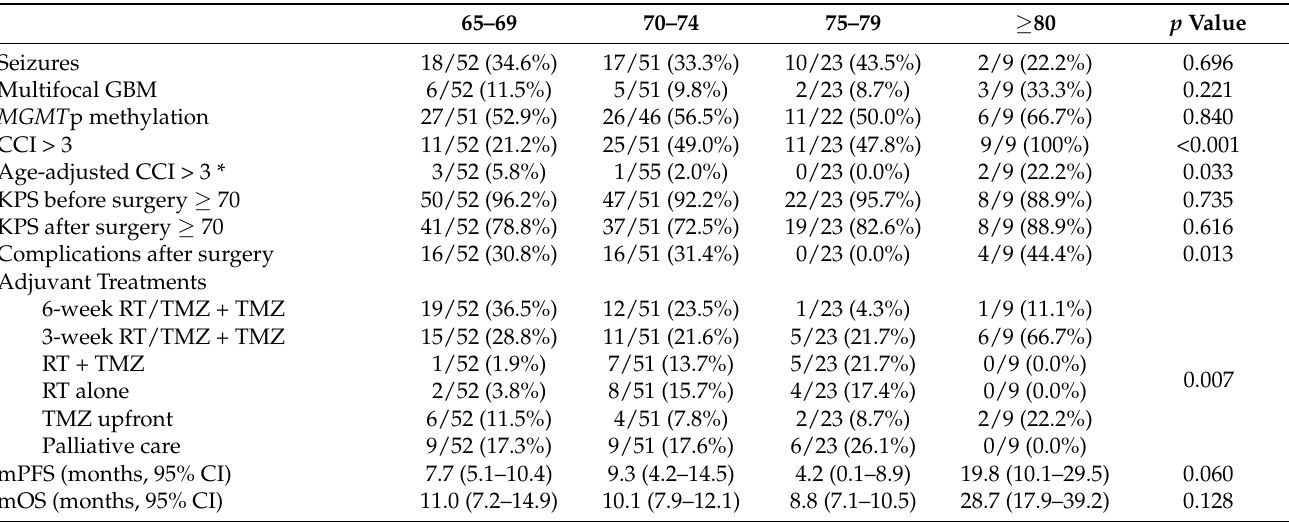
Table 3. Distribution of clinical characteristics within different classes of